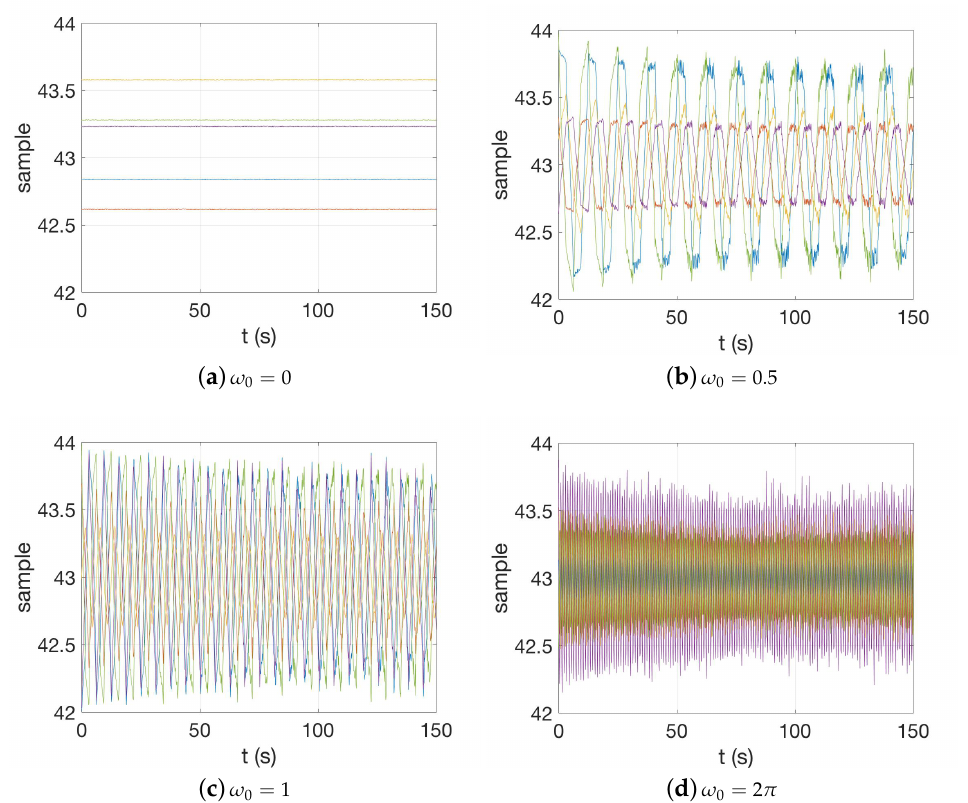
Figure 6. Samples with correlation function, r xx = Cos ( ω 0 τ ) , at different values of ω 0